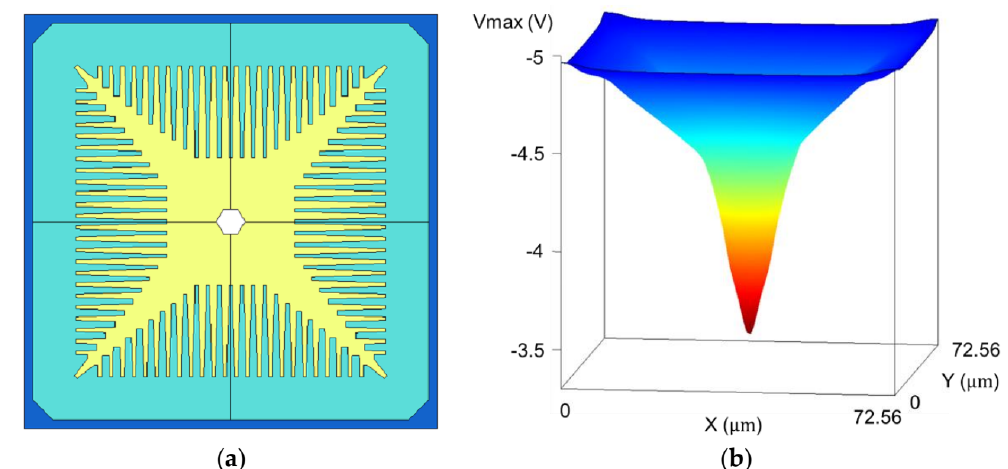
Figure 4. Three masks to create the p-well and the resultant potential profile (superposed). ( a ) The following three masks to create the linear p-well potential: mask 1 (yellow) covering the whole area except the center hole, mask 2 (light blue) with the comb-like structure, and mask 3 (blue) like a frame along the pixel boundary. The implantation energies are also different. ( b ) The potential profile over the p-well made with the masks (the linear potential is created, except the area near the center and the boundary of the pixel).